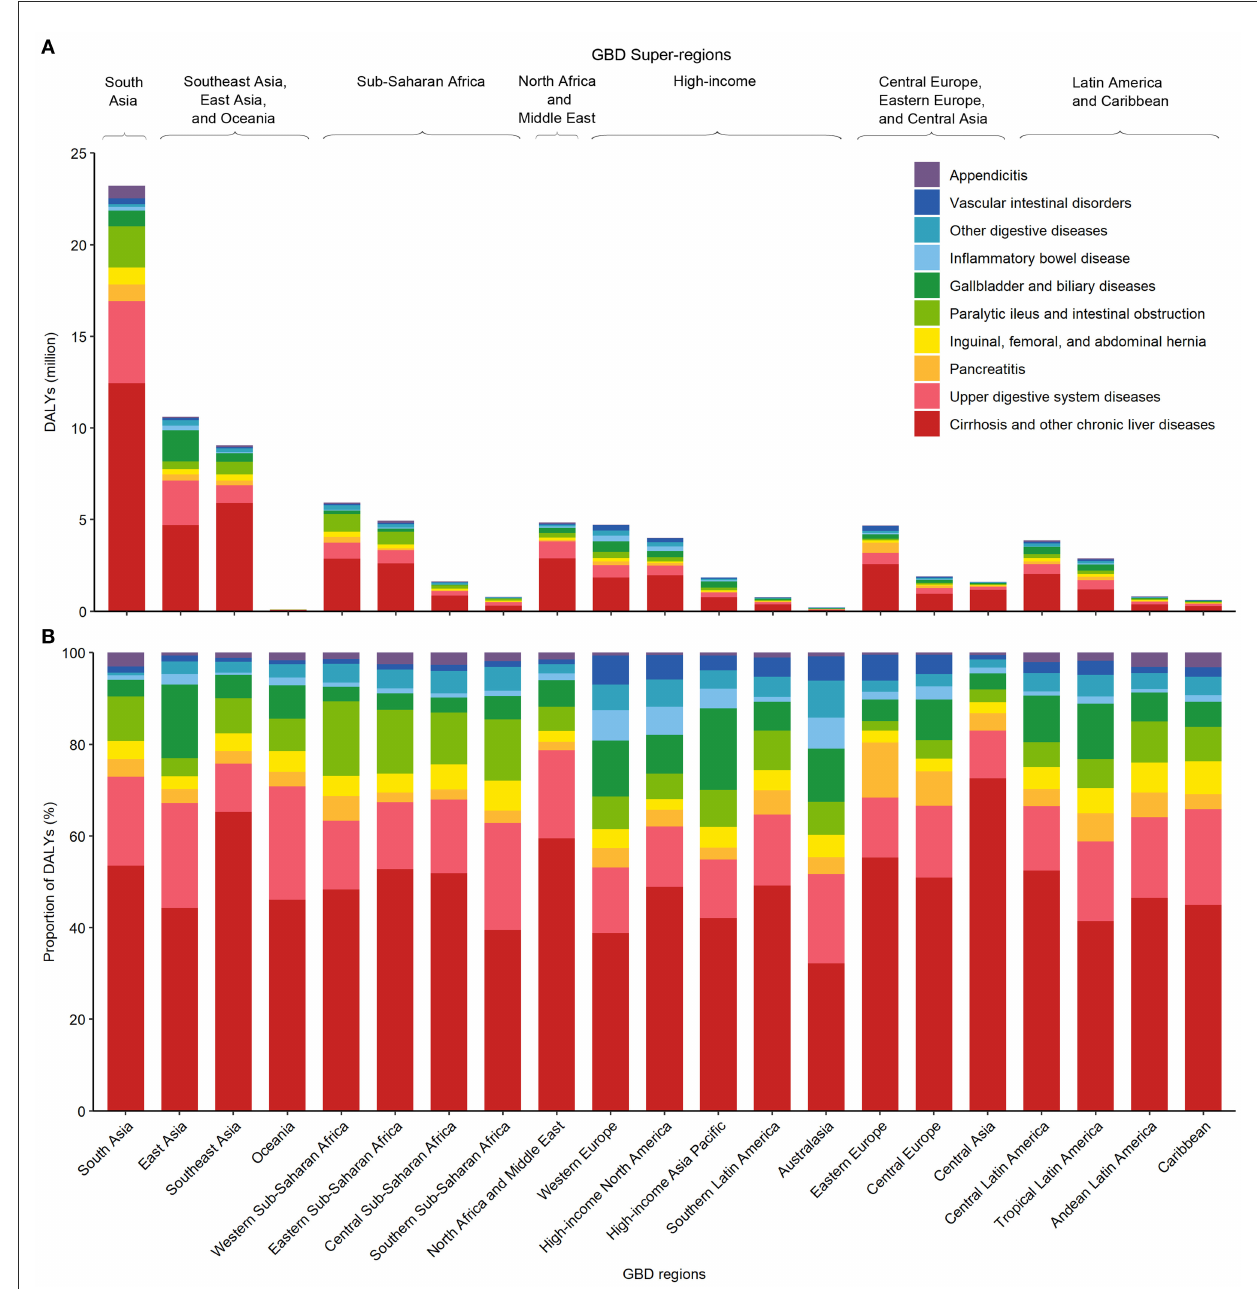
FIGURE3 The absolute (A) and proportional (B) DALYs due to various digestive diseases by GBD world region, both sexes combined, 2019. DALY, disability-adjusted life-year; GBD, Global Burden of Disease, Injuries, and Risk Factors Study.